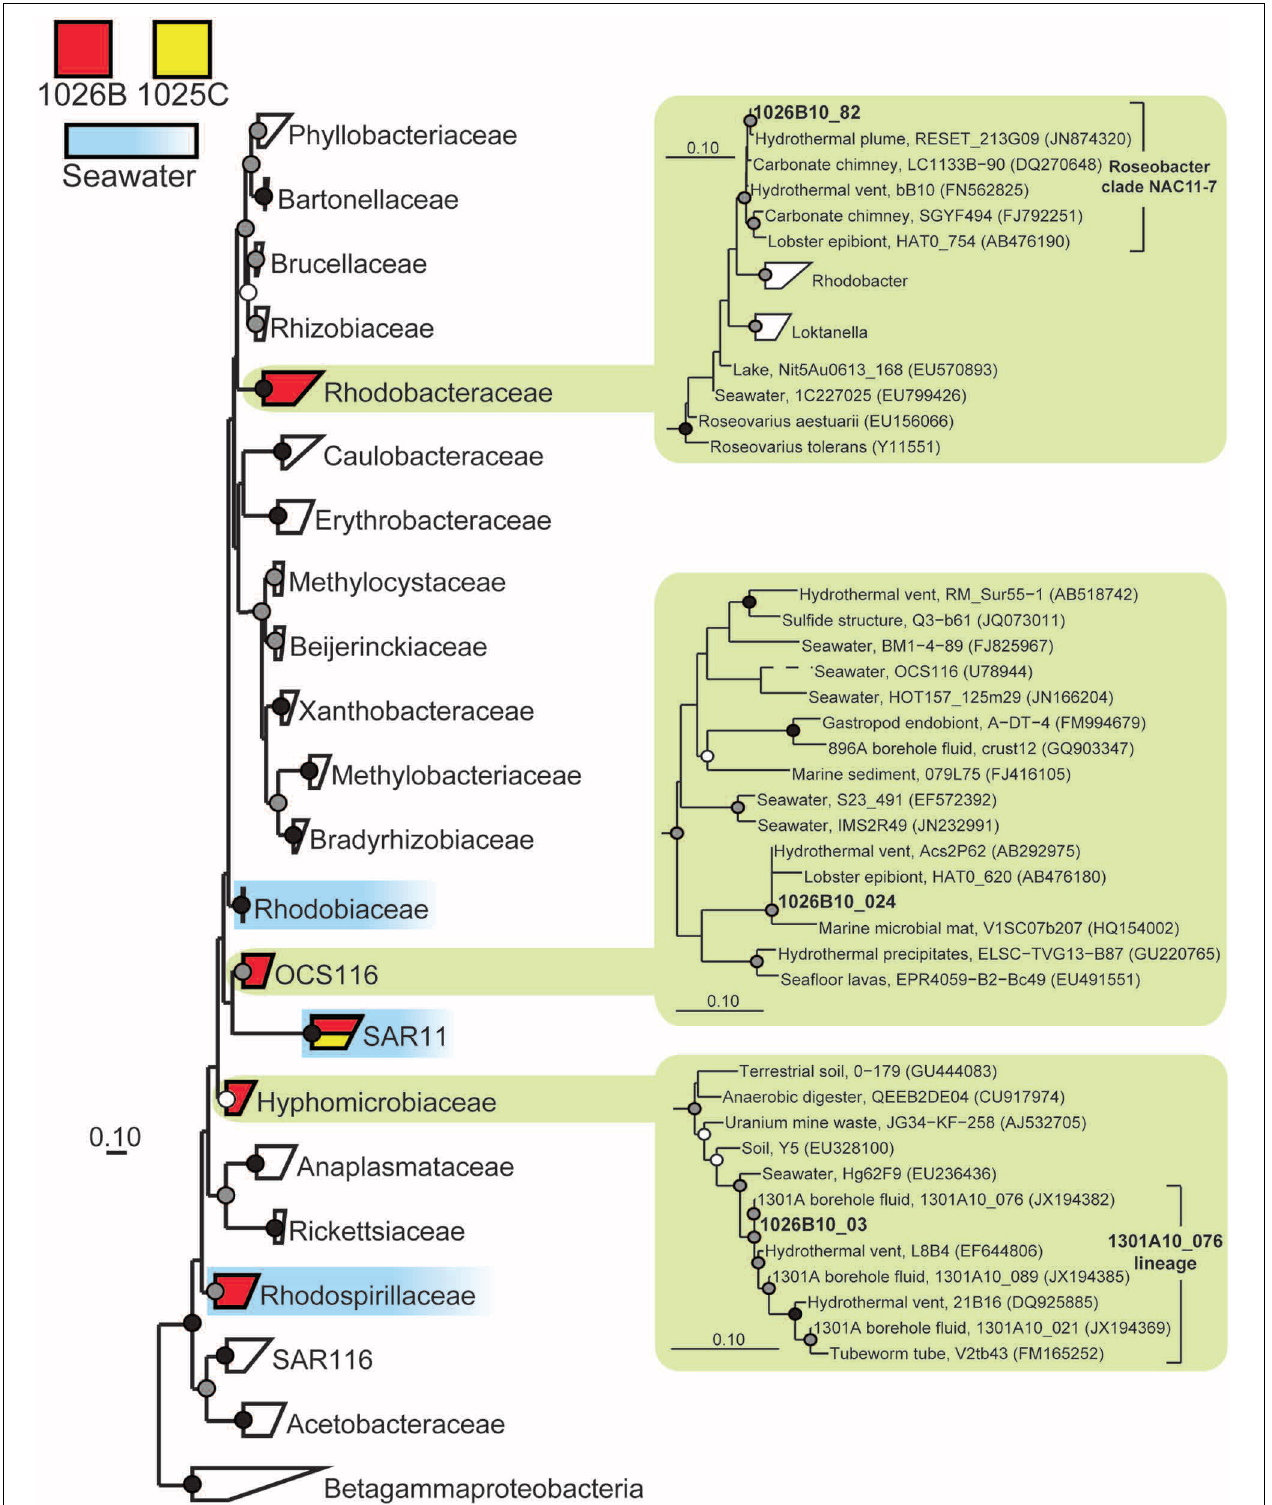
FIGURE 6 | Phylogenetic relationships of SSU rRNA gene clones related to the phylum Alphaproteobacteria , colored as in Figure 3. Detailed phylogenies are shown for selected lineages. Short length